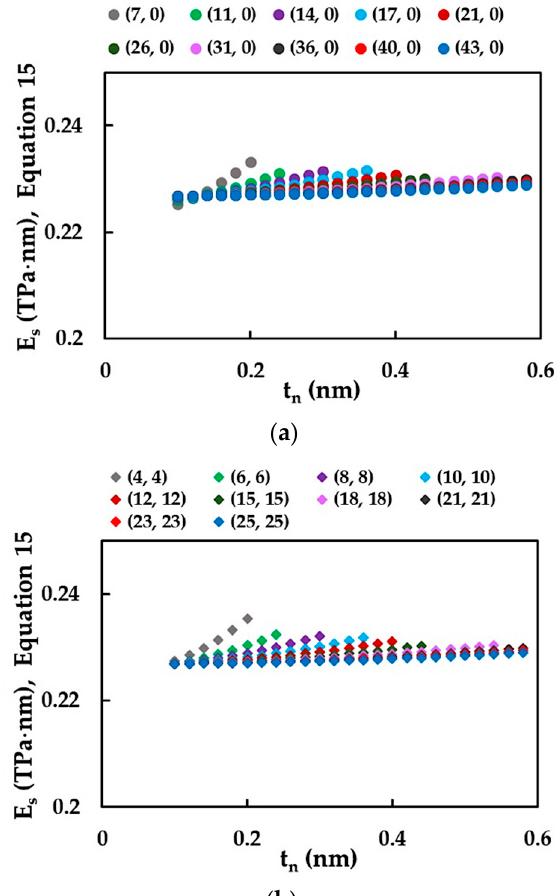
Figure 8. Evolution of the surface Young’s modulus, E S , calculated with help of Equation (15), as a function of the wall thickness, t n , for ( a ) zigzag and ( b ) armchair SWSiCNTs.